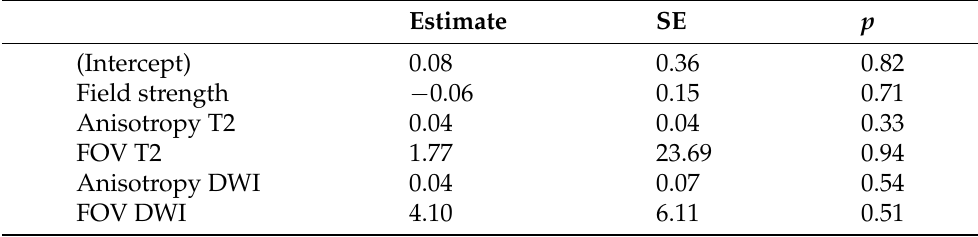
Table 4. Association between field strength, anisotropy T2 and DWI, field-of-view (FOV) T2 and DWI, and DSC using multiple linear regression. None for the MRI acquisition features had a statistical assocation to segmentation performance ( p ≥ 0.33, multiple linear